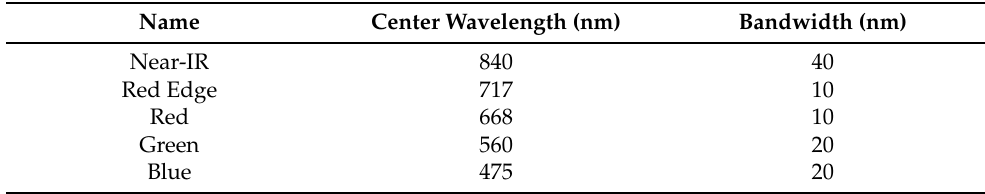
Table 1. Specification of multispectral image sensor [26].